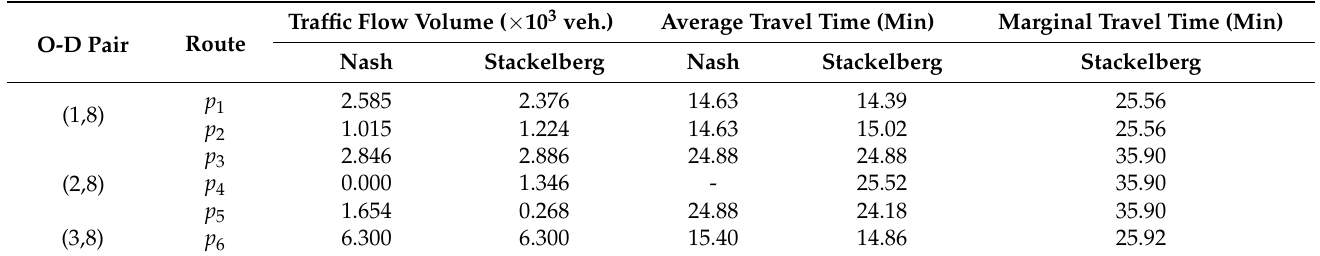
Table 6. Results of optimization with the Nash and Stackelberg approaches for movement routes in scenario #2.